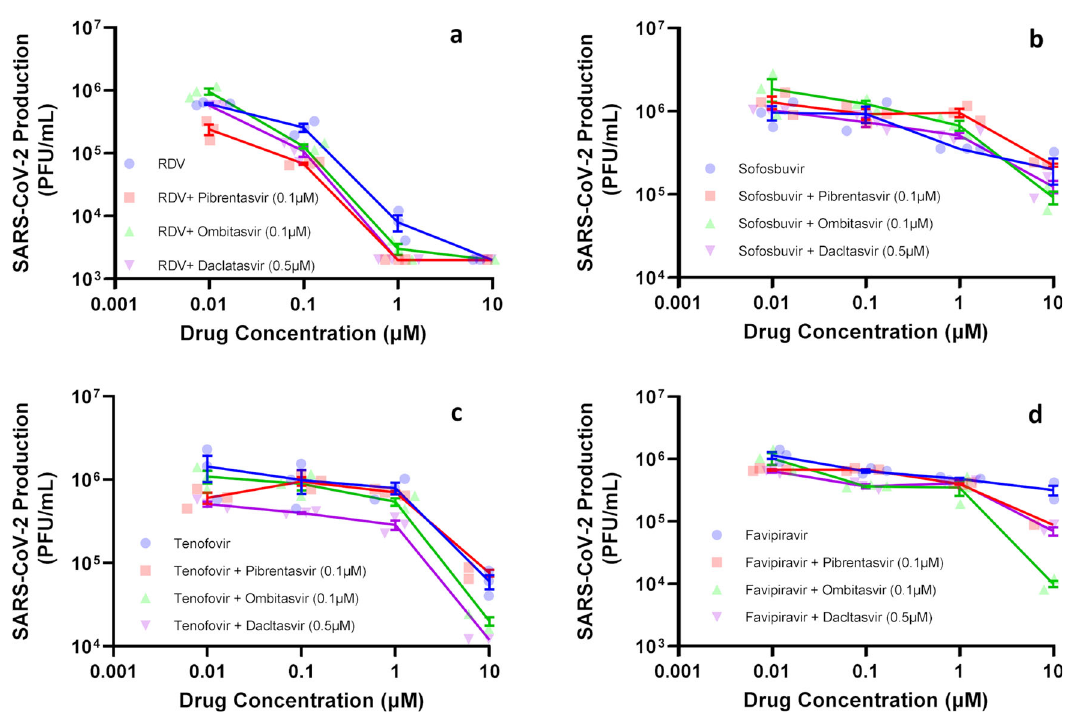
Fig. 7 Antiviral activity of combinations of SARS-CoV-2 polymerase and exonuclease inhibitors. Calu-3 cells, at a density of 5 × 10 5 cells/well in 48-well plates, were infected with SARS-CoV-2 at a MOI of 0.1, for 1 h at 37 °C. An inoculum was removed and cells were washed and incubated with fresh DMEM containing 10% FBS and the indicated concentration of Remdesivir (RDV) ( a ), Sofosbuvir ( b ), Tenofovir ( c ), and Favipiravir ( d ), alone and in combination with the HCV NS5A inhibitors. Supernatants were assessed after 48 – 72 h. Viral replication in the culture supernatant was measured as PFU/mL by titering in Vero E6 cells. Results are displayed as virus titers. The data represent means ± SEM of three independent experiments.